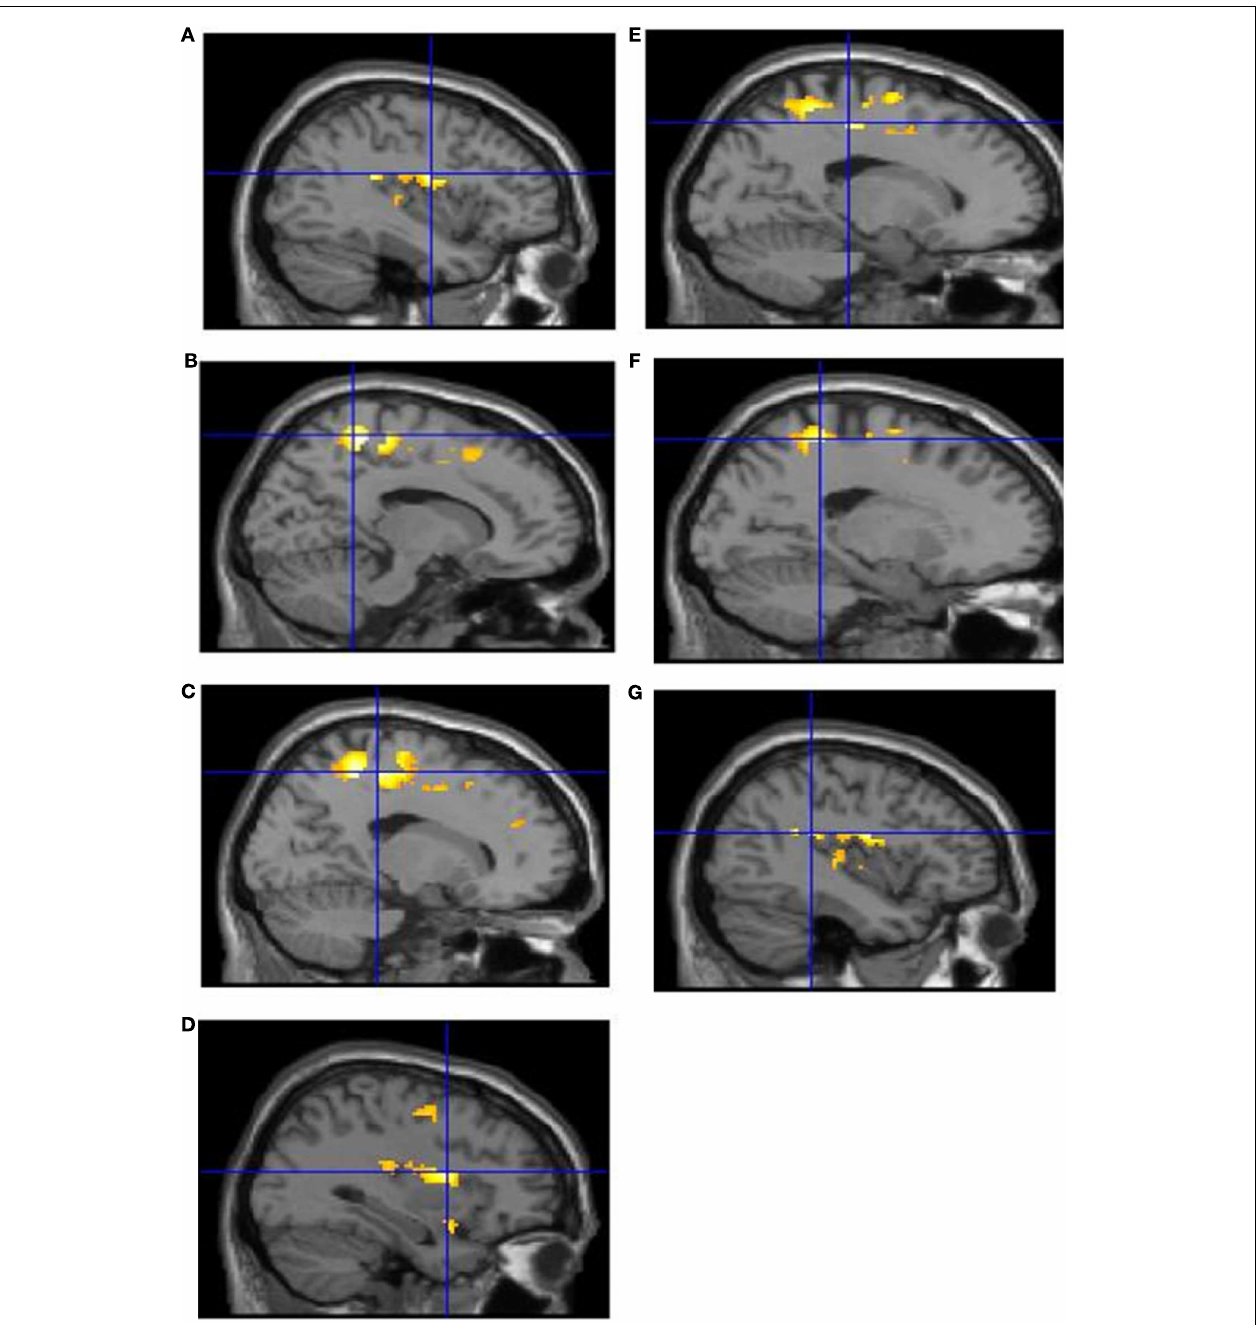
FIGURE 2 |Activations reflecting the interaction between factors of “intentionality” and “causality” from the ROI analysis in: left mid-insula (A); right superior parietal cortex (B); right motor cortex (C); right anterior insula (D); left motor cortex (E); left superior parietal cortex (F); left posterior insula